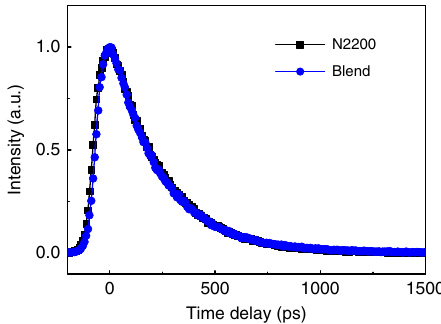
Fig. 4 Exciton dynamics in the neat acceptor and blend fi lms. TRFL spectra of the neat fi lm of N2200 and the blend fi lm recorded at 1.45